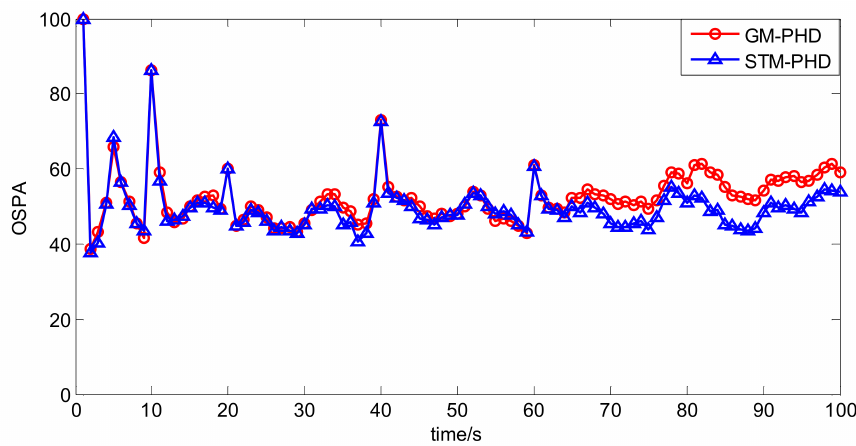
Figure 11. Comparison of OSPA distance of two filters with fixed clutter rate ( λ c = 20).